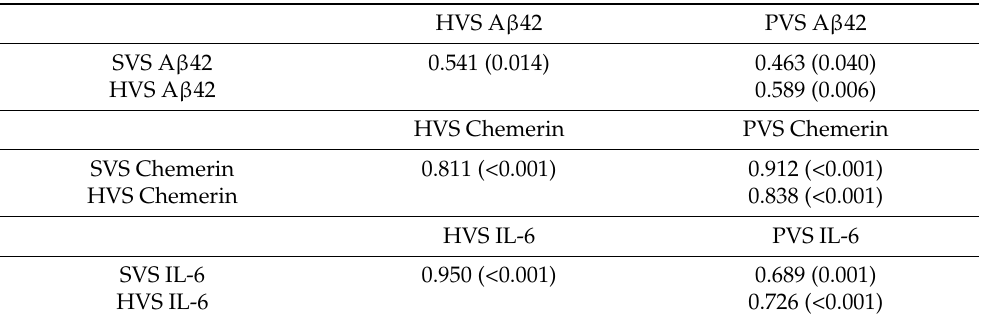
Table 2. Spearman correlation coefficients and p -values (in brackets) for chemerin, IL-6, and A β 42 levels in the blood